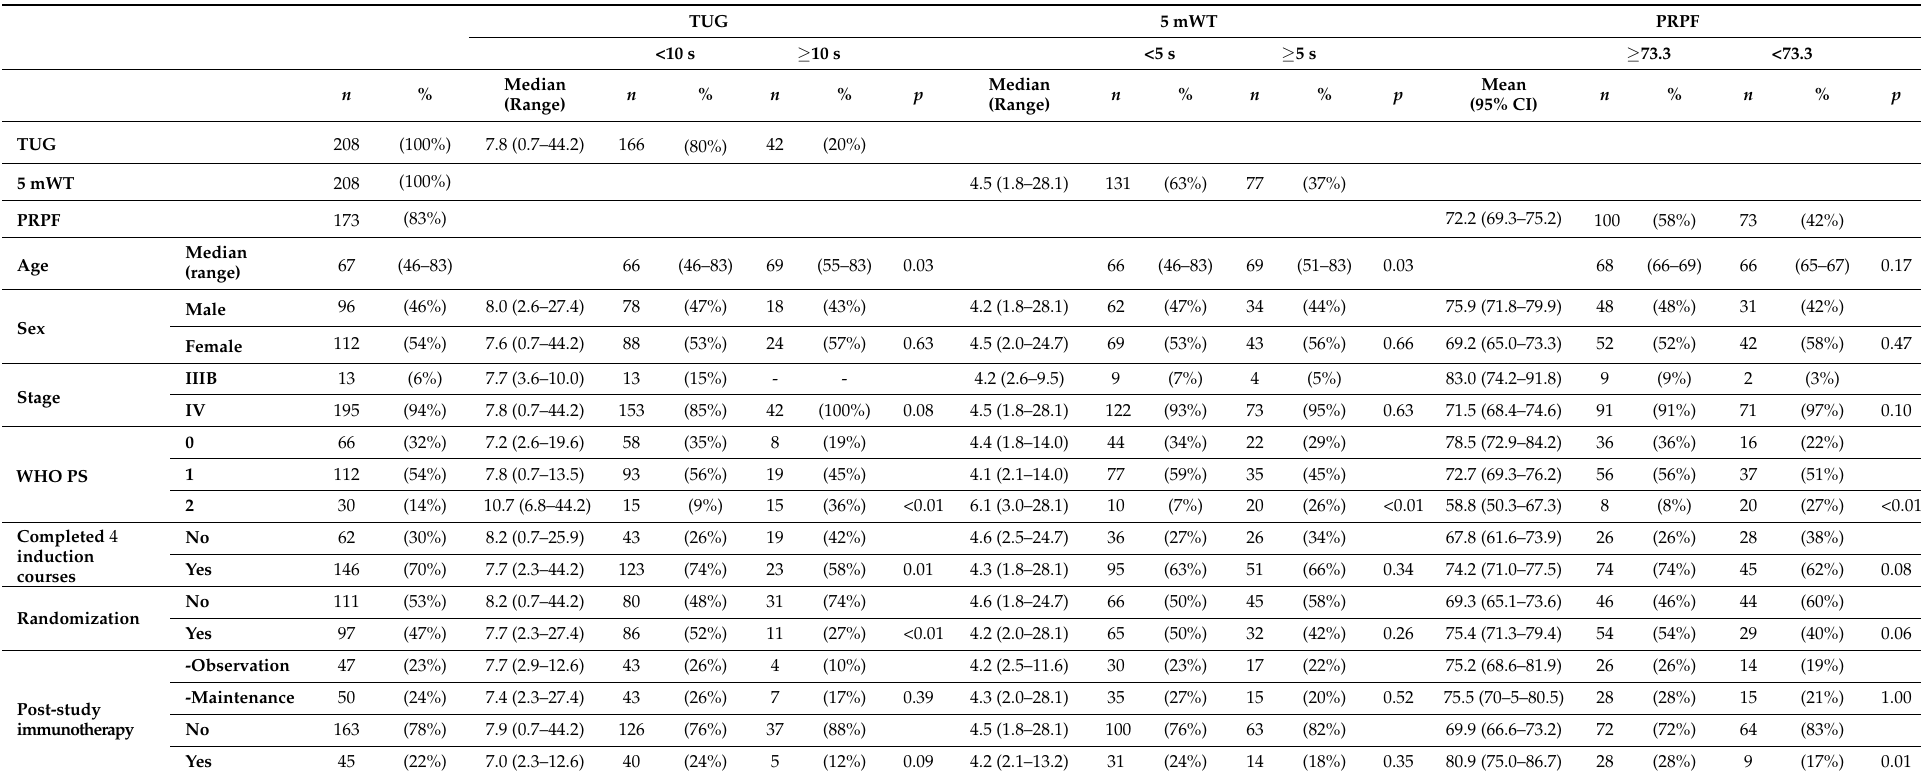
Table 1. Patient and treatment